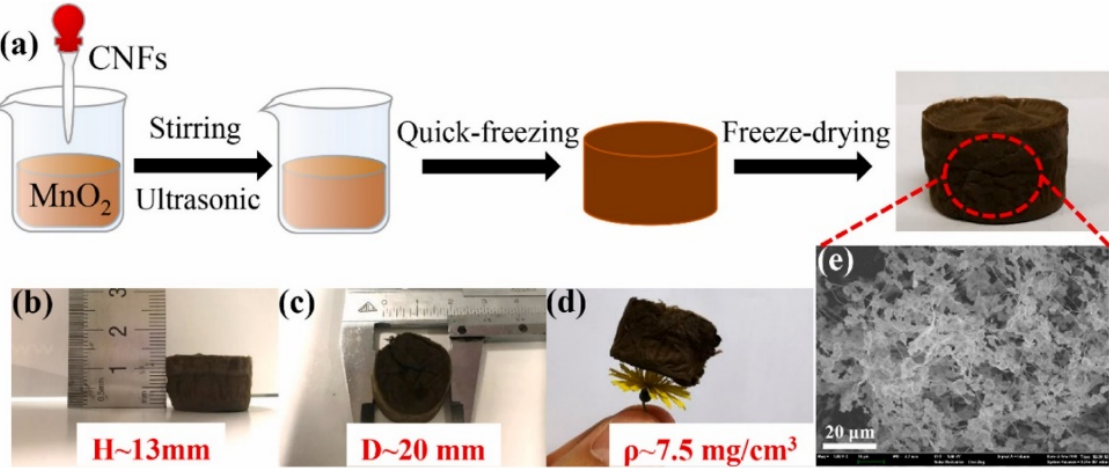
Figure 5. Preparation of macroporous MnO 2 -based aerogel crosslinked with cellulose nanofibers. ( a ) scheme for the synthesis of cellulose nanofibers/MnO 2 hybrid aerogels; ( b – d ) the height, diameter and density of cellulose nanofibers/MnO 2 hybrid aerogel; ( e ) the SEM image of cellulose nanofibers/MnO 2 hybrid aerogel. Adapted with permission from Cao et al. [75]. Copyright (2021) Elsevier.